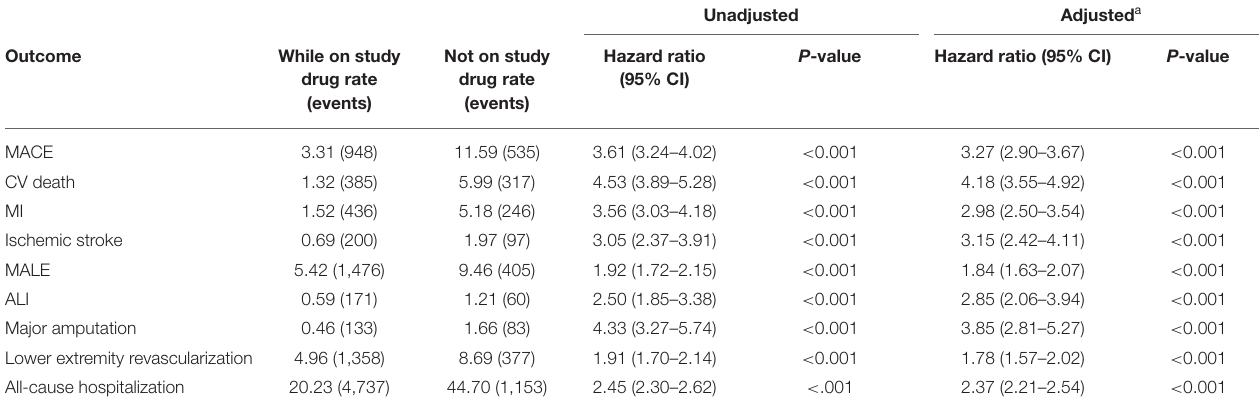
TABLE 4 | Association between (time-dependent) premature study drug discontinuation and clinical outcomes.